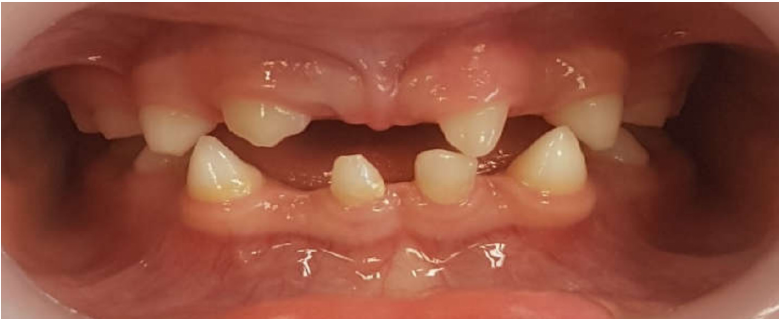
Figure 1. Ten-year-old boy presenting with tooth agenesis.